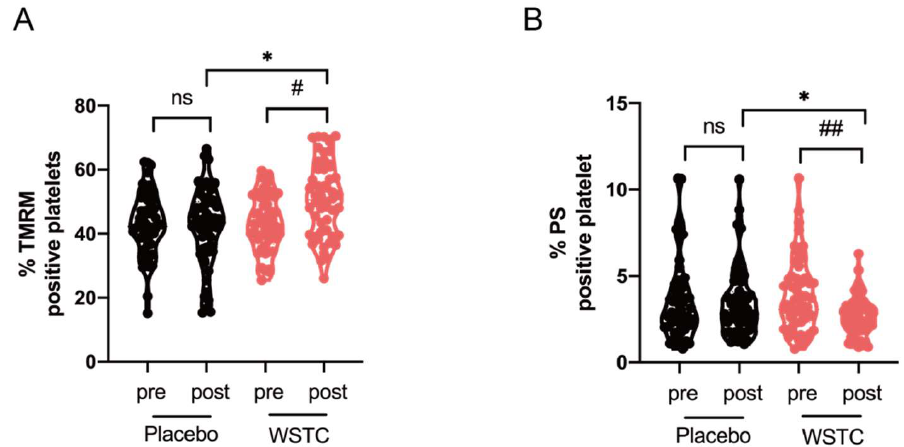
Figure 4. Effect of WSTC supplementation on ∆Ψ m dissipation and PS exposure in healthy middle- aged and elderly adults. Human wash platelets were prepared from volunteers before (pre) and after (post) 4 weeks of WSTC or placebo consumption. ( A ) Platelet ∆Ψ m dissipation was measured using TMRM by flow cytometry. ( B ) Annexin V-PE was used to assess platelet PS exposure by flow cytometry. At baseline, there was no significant difference in any variable for ∆Ψ m dissipation and PS exposure between the two groups. * p < 0.05, one-way analysis of variance for independent data was used for comparison between the two groups after 4 weeks of intervention. # p < 0.05 and ## p < 0.01 vs. baseline in the WSTC group, assessed by a paired Student’s t -test. Abbreviations: PS, phosphatidylserine and WSTC, water-soluble tomato concentrate.